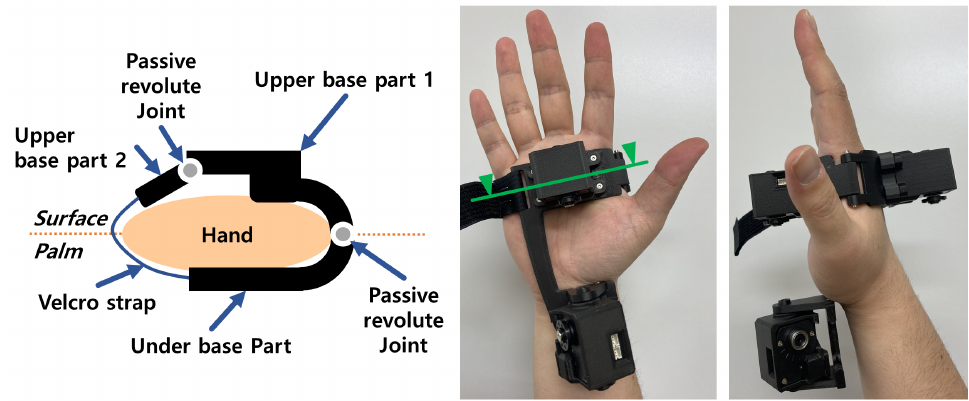
Figure 14. The cross-section of base parts and the attached state of the base with